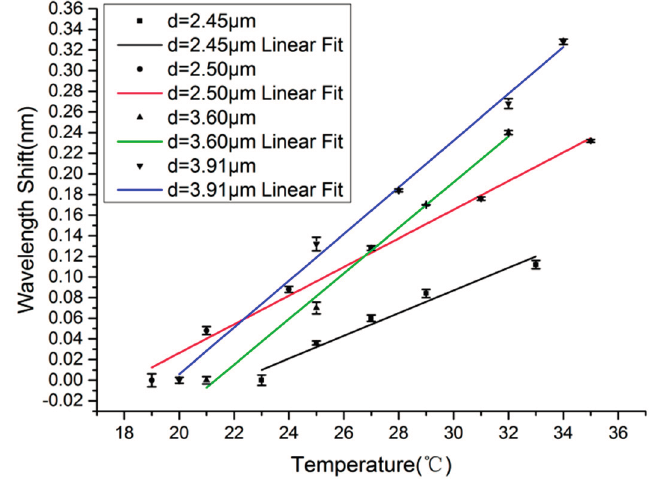
Figure 7. The linear fittings of resonant wavelength with temperature for MKRs with fiber diameters of 2.45-, 2.50-, 3.60- and 3.91- μ m. The error bars show the differences between experimental and fitting results.